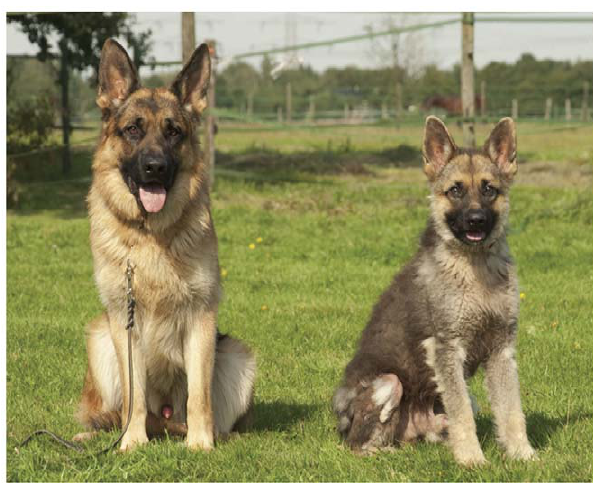
Figure 1. Two fourteen-month-old male German shepherd dogs from the same litter. A healthy German shepherd dog (C8, left) and his littermate that is affected by pituitary dwarfism (C6, right). Note the proportionate growth retardation, the retention of puppy hairs and the lack of guard hairs of the dwarf.